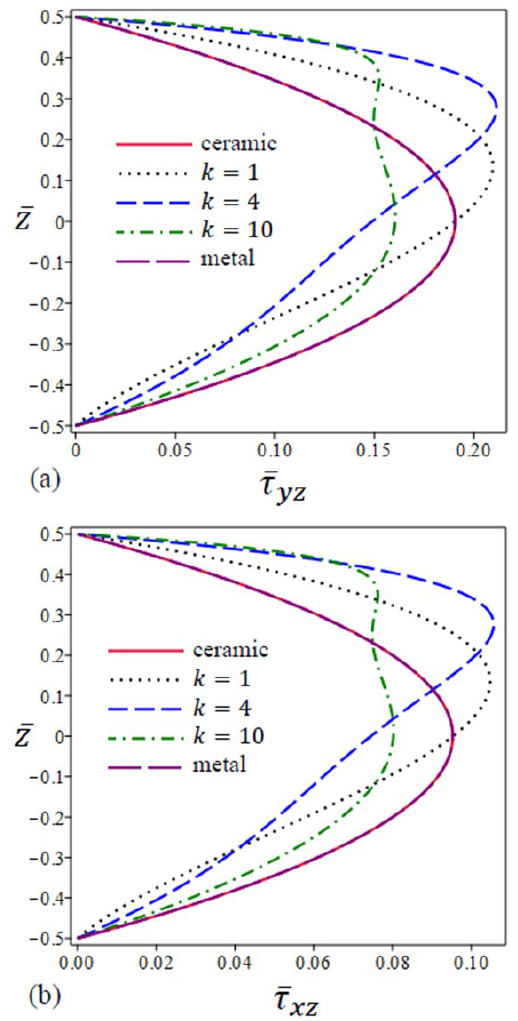
Figure 11: The transverse shear stresses across the thickness of a FG plate: (a) τ yz , (b) τ xz .